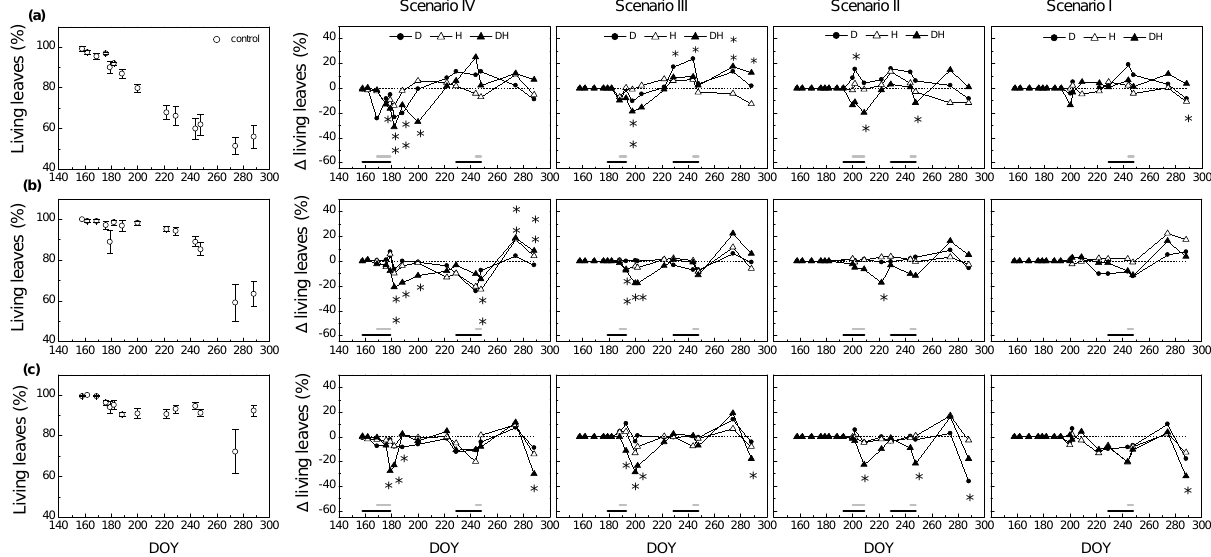
Fig. 3. Course of the percentage of living leaves, per species, for (a) Rumex acetosella , (b) Plantago lanceolata and (c) Bellis perennis . Control values are given (left panel) and the difference between the controls and the treatments during the different scenarios. Standard errors are displayed for the controls but are not shown for the other treatments for improved clarity. D = drought (closed circles), H = heat (open triangles), DH = drought + heat (closed triangles). Bottom lines in each graph indicate timing of the climate events (black line = drought, grey line = heat wave). Asterisks, arranged in the same vertical order as the points, indicate significant differences ( P < 0 . 05) between treatments and control on that day. DOY = day of